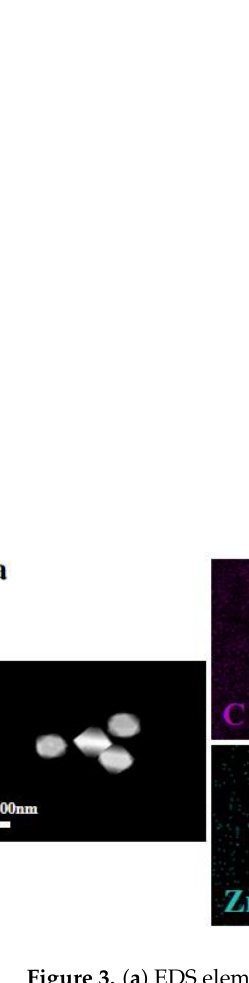
Figure 3. ( a ) EDS element mapping of UiO-66-NH 2 @PDA; ( b ) FT-IR spectra of UiO-66-NH 2 and UiO-66-NH 2 @PDA.